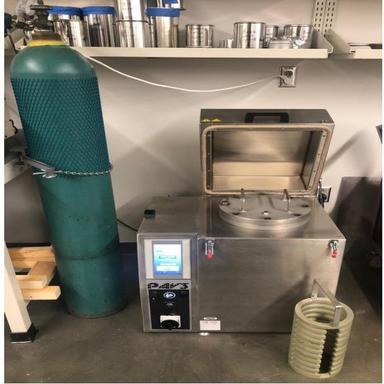
The PAV apparatus at MAPIL.